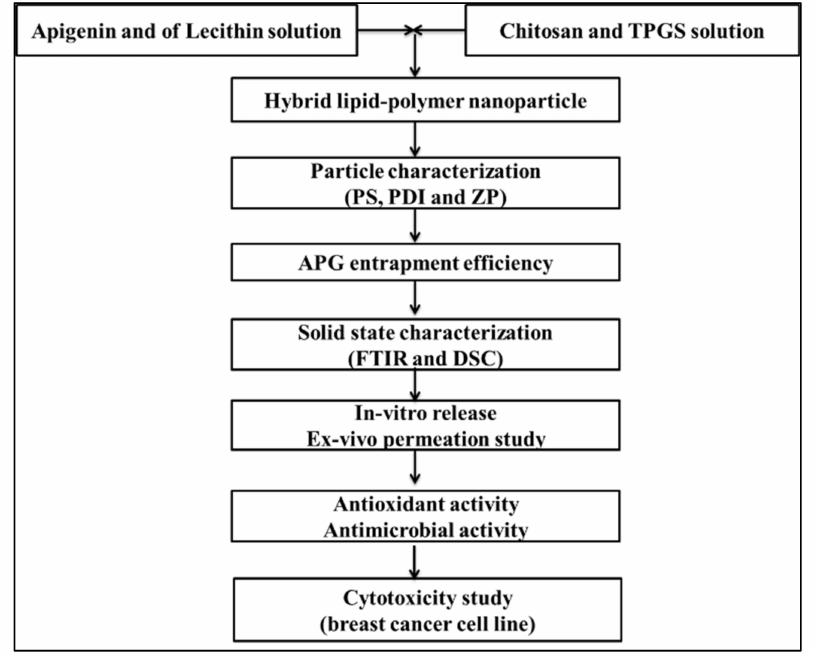
Figure 1. Flow chart of experimental